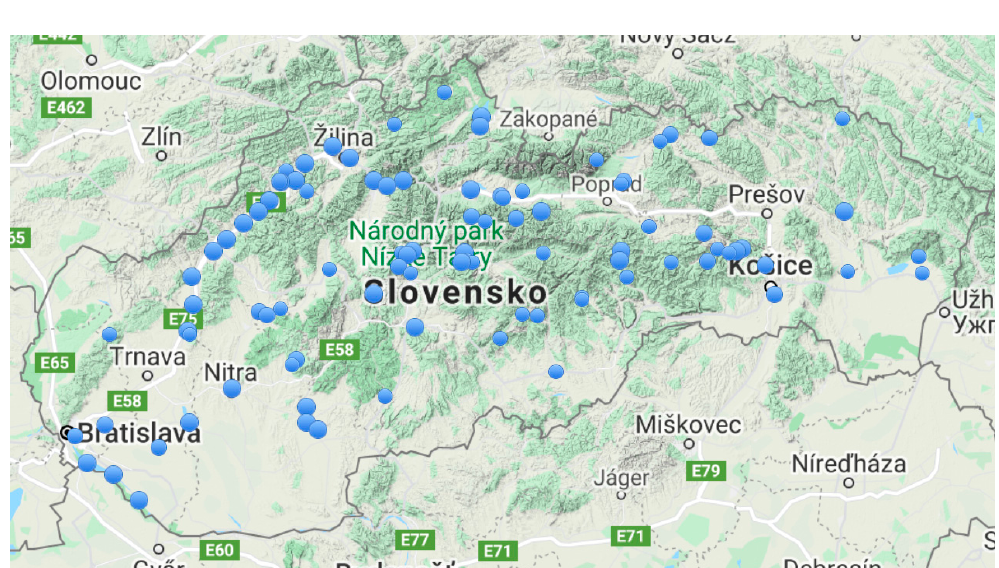
Figure 31. Location of hydropower plants of Slovak Republic [24].